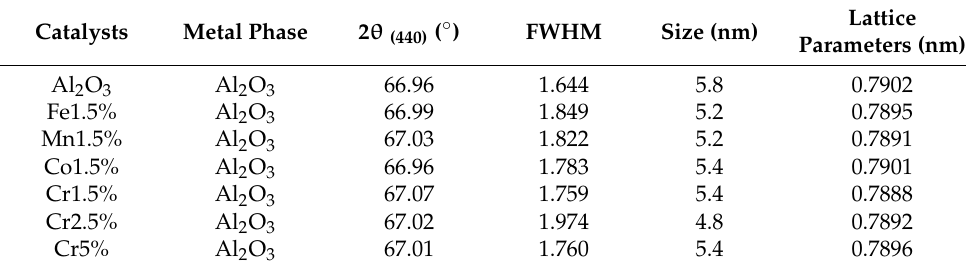
Table 2. Crystallite phases and sizes of Al 2 O 3 in catalysts.